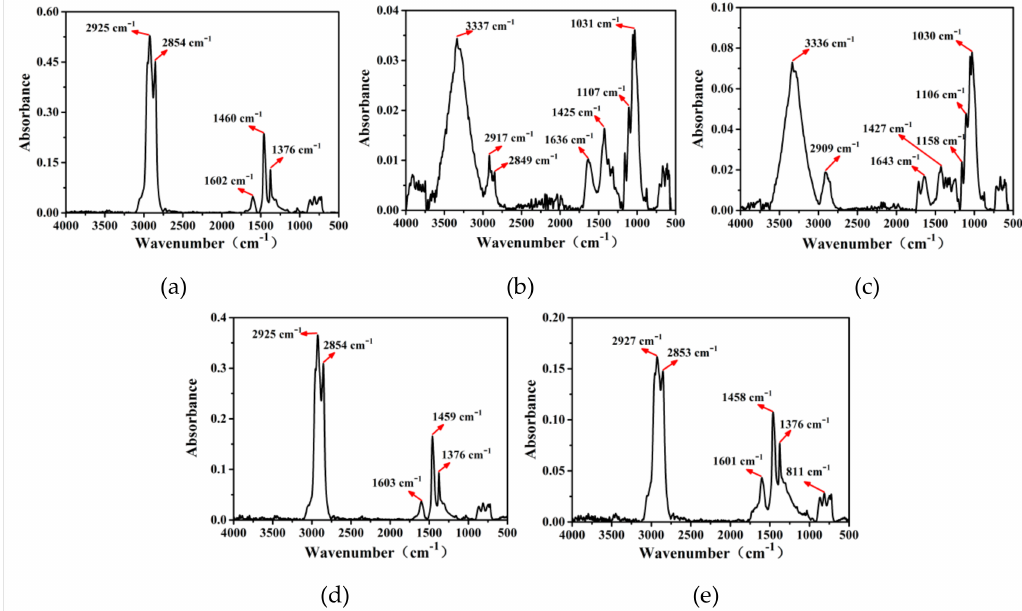
Figure 10. Fourier-transform infrared spectroscopy (FTIR) test results: ( a ) raw bitumen; ( b ) GL; ( c ) FL; ( d ) GLA and ( e )